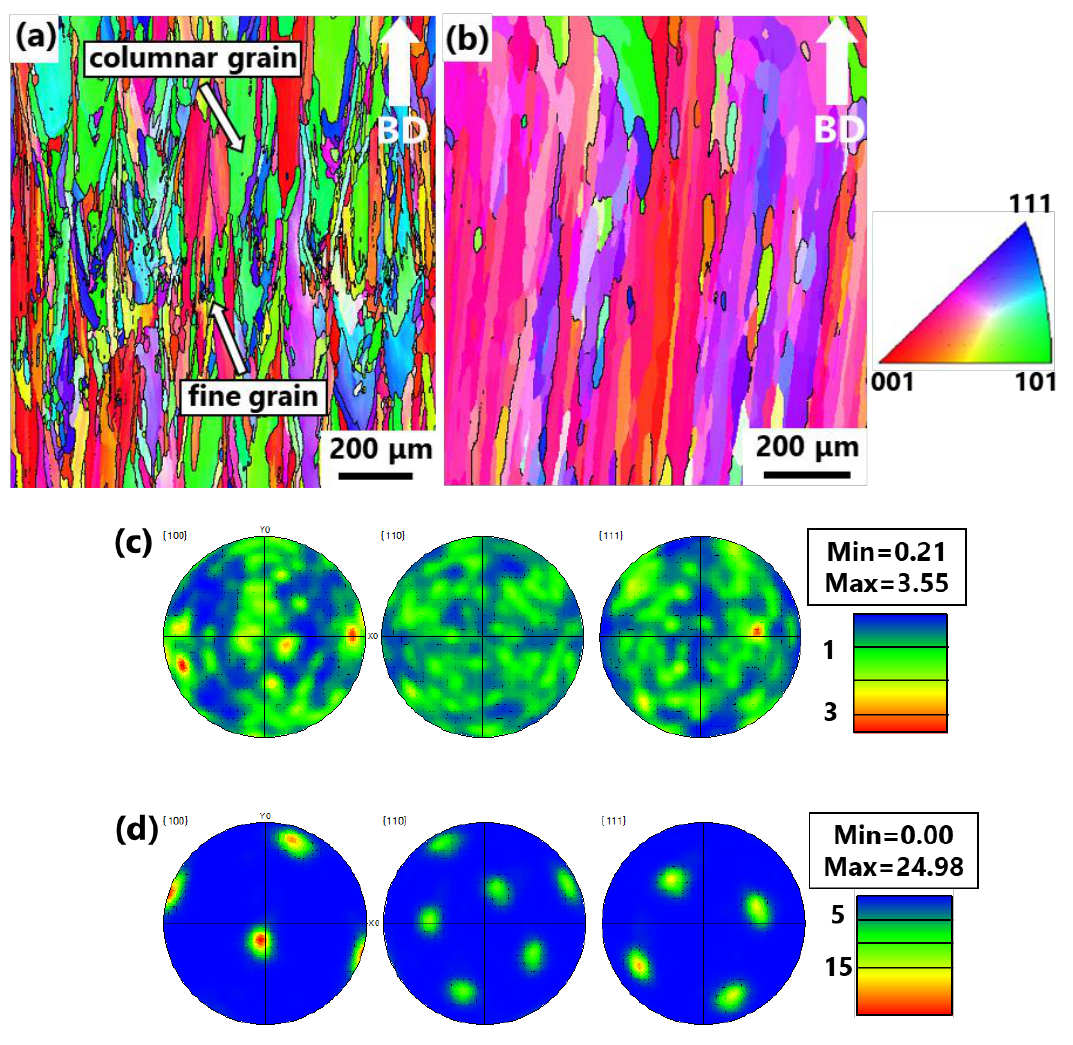
Figure 3. Inverse pole figure (IPF) maps of the as-built specimens: ( a ) Ar-SLM and ( b ) V-SLM. Pole figure maps of the as-built specimens: ( c ) Ar-SLM and ( d ) V-SLM.